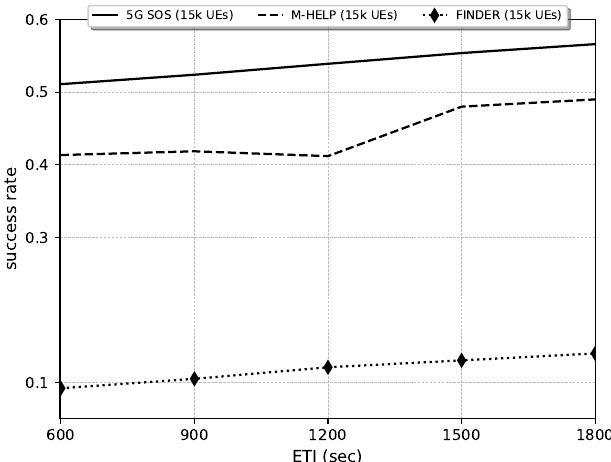
Figure 8. Comparison of successful rate against emergency time interval (ETI) under 5G-SOS, M- HELP, and FINDER. Parameters: ETI: 600–1800 s, NoU: 15,000, NEC: 5000.